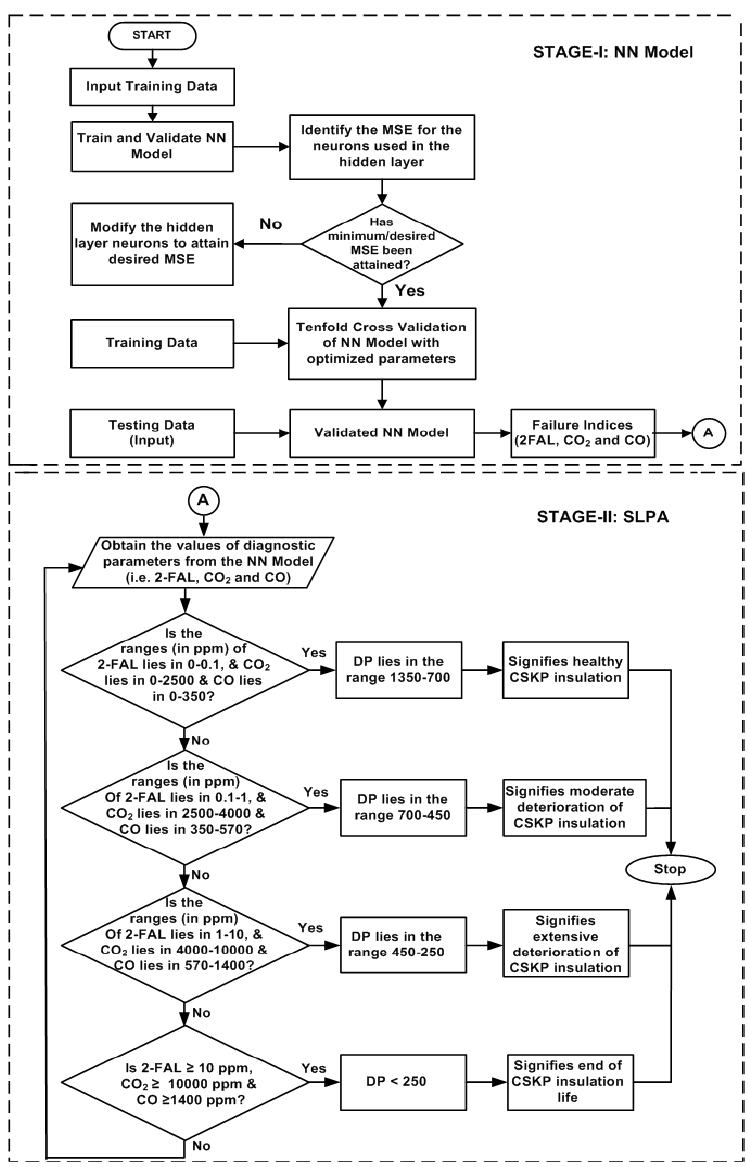
Figure 3. Flow-chart of integrated insulation health assessment system.